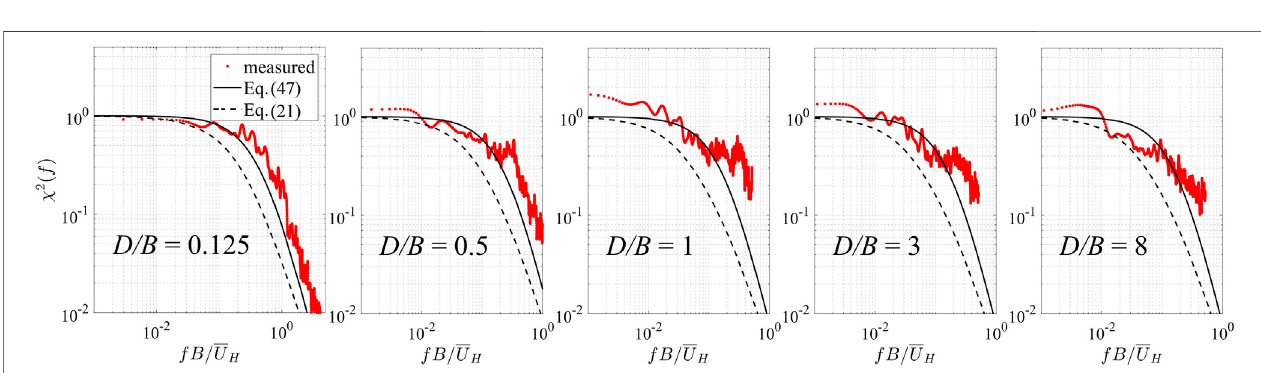
FIGURE 9 | Aerodynamic admittance functions for drag coef fi cients.